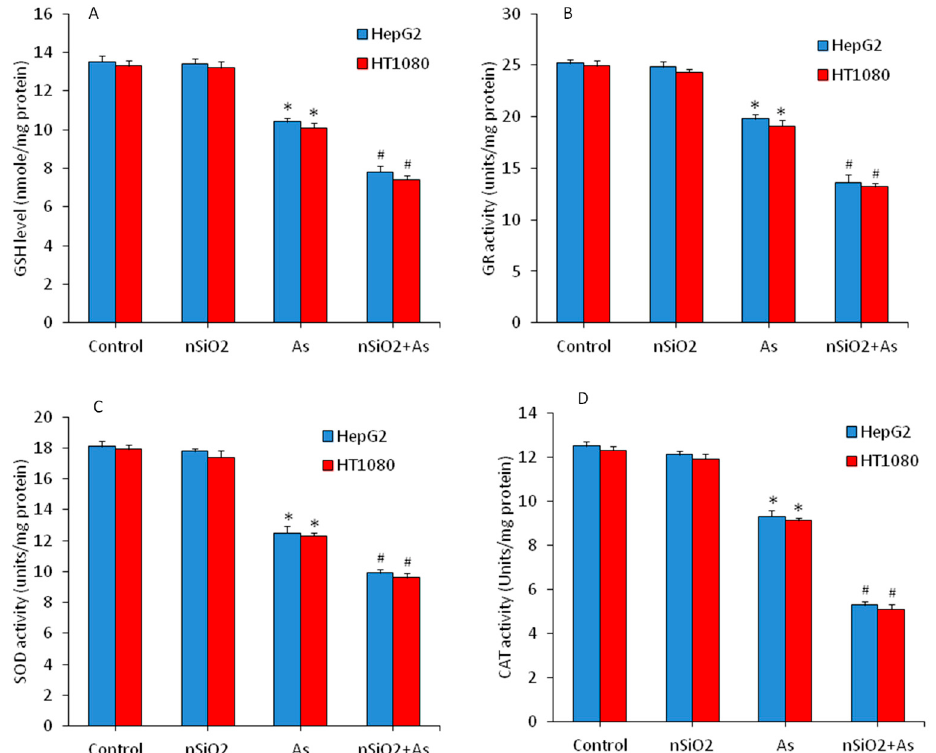
Figure 4. Antioxidant levels in HepG2 and HT1080 cells after exposure to nSiO 2 (10 μ g/mL), As (1 μ g/mL) or SiO 2 + As (10 μ g/mL + 1 μ g/mL) for 24 h. ( A ) Intracellular glutathione (GSH) level. ( B ) Glutathione reductase (GR) enzyme activity. ( C ) Superoxide dismutase (SOD) enzyme activity. ( D ) Catalase (CAT) enzyme activity. Data are presented as the mean ± SD of three independent experiments (n = 3). * indicates significant effect in comparison to the control group ( p < 0.05). # indicates significant effect in comparison to the nSiO 2 group alone or As group alone ( p < 0.05).